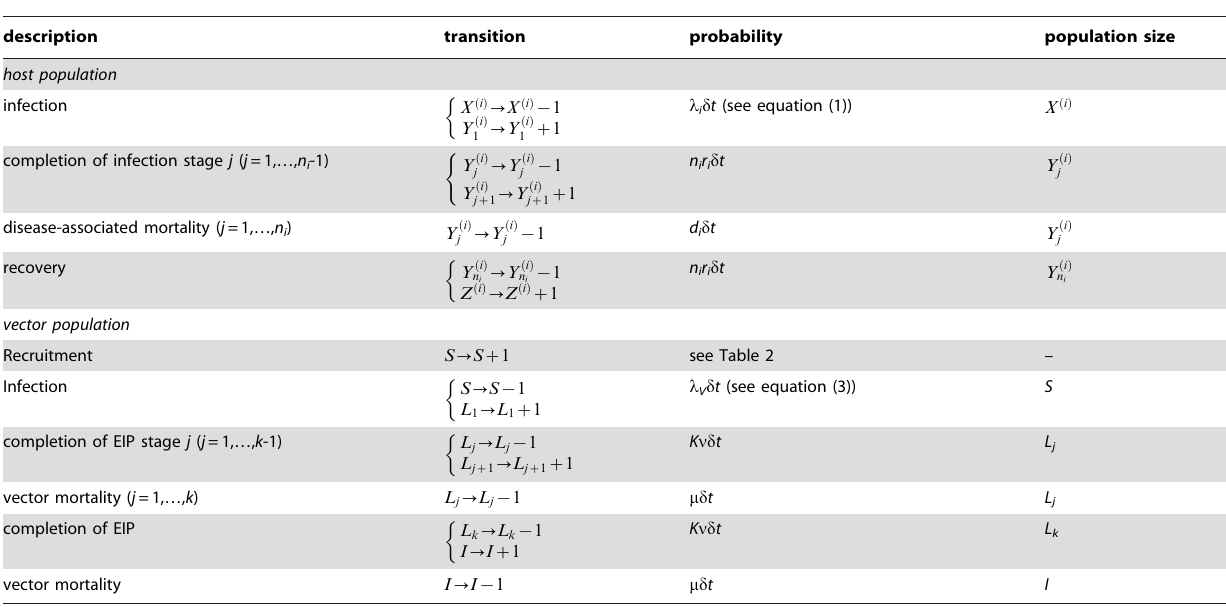
Table 1. Transitions, probabilities, and population sizes in the model for the transmission of BTV within farms { .